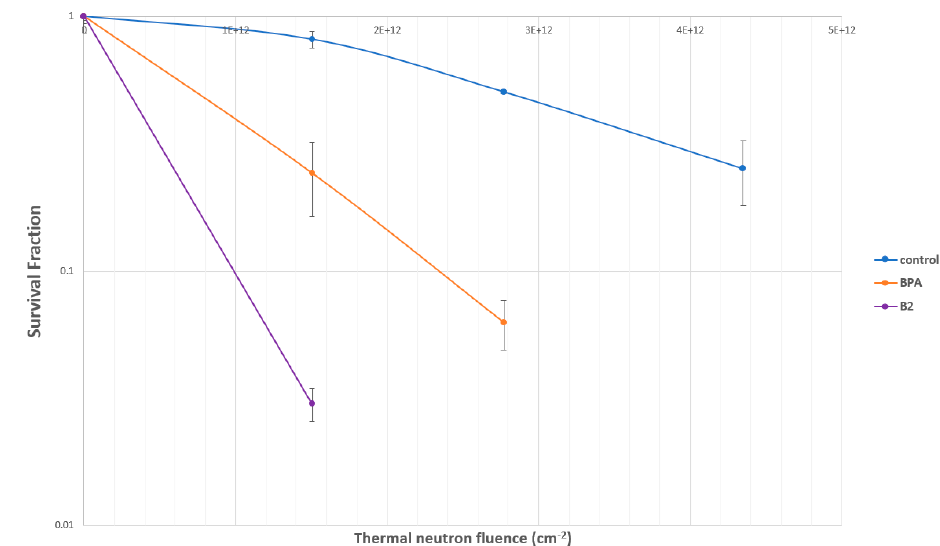
Figure 7. Cell survival curves for glioma U87 delta EGFR cells after BNCT with hydroxamate 2 ( B2 ).